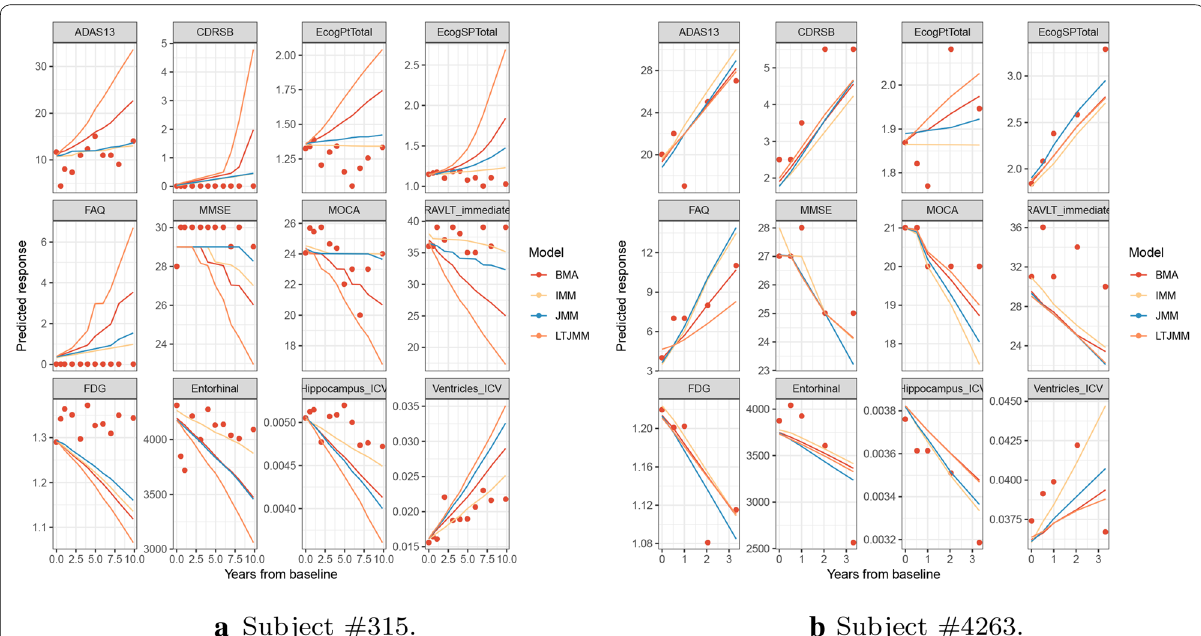
Fig. 9 Observed values (points) versus predicted lines (lines) based on only their baseline data for each of the four modeling approaches for subject#314 and for subject#4263. IMM Independent mixed-effects model, JMM joint mixed-effects model, LTJMM latent-time joint mixed-effects model, BMA Bayesian model averaging, ADAS13 Alzheimer’s Disease Assessment Scale, CDRSB Clinical Dementia Rating—Sum of Boxes, EcogPtTotal everyday cognition participant, EcogSPTotal everyday cognition study partner, FAQ Functional Assessment Questionnaire, FDG FluoroDeoxyGlucose, MMSE Mini-Mental State Examination, MOCA Montreal Cognitive Assessment, RAVLT Rey Auditory Verbal Learning Test, ICV intracranial